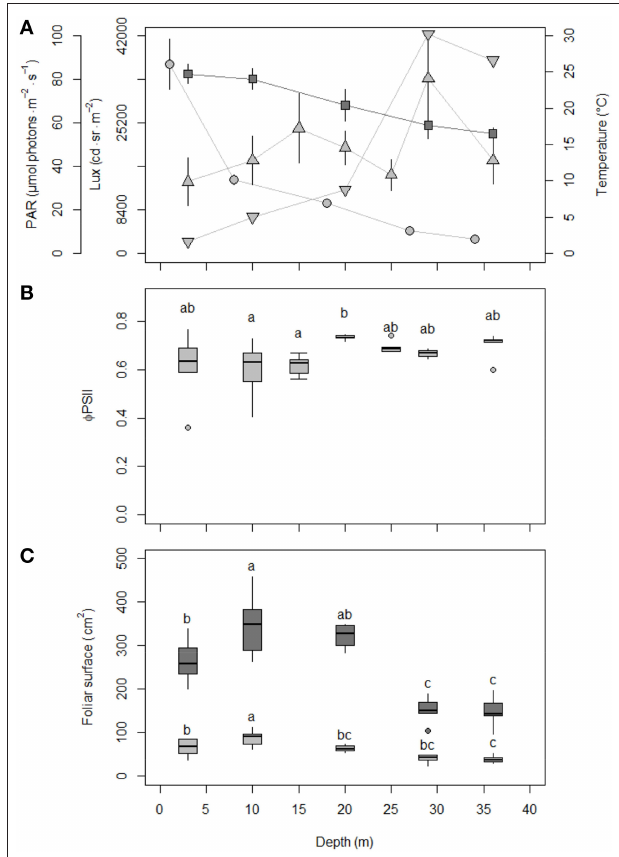
FIGURE 2 | Evolution of environmental and seagrass biological parameters in P. oceanica meadow along the 3–36m depth transect. (A) Temperature ( ◦ C; dark gray squares; mean ± sd, n = 23) and light recorded above the meadow canopy (lux, cd.sr.m − 2 ; light gray dots; mean ± sd, n = 23) or within the meadow canopy (photosynthetically active radiation (PAR), µ mol photons.m − 2 .s − 1 ; light gray triangles; n = 6 at all depths except 10m, n = 24). For comparison purpose between depths, mean PAR recorded during dives were normalized by mean lux of corresponding days (flipped light gray triangles, no scale). (B) Boxplot of the effective quantum yield of photosystem II ( 8 PSII) of P. oceanica third leaf. (C) Boxplot of P. oceanica shoot (dark gray) and third leaf (light gray) foliar surfaces (cm 2 ). Letters on boxplots (B,C) represent significant differences (one-way ANOVA and Tukey test) in mean 8 PSII or mean foliar surfaces between depths, respectively ( n = 6 at all depths except 10m, n =